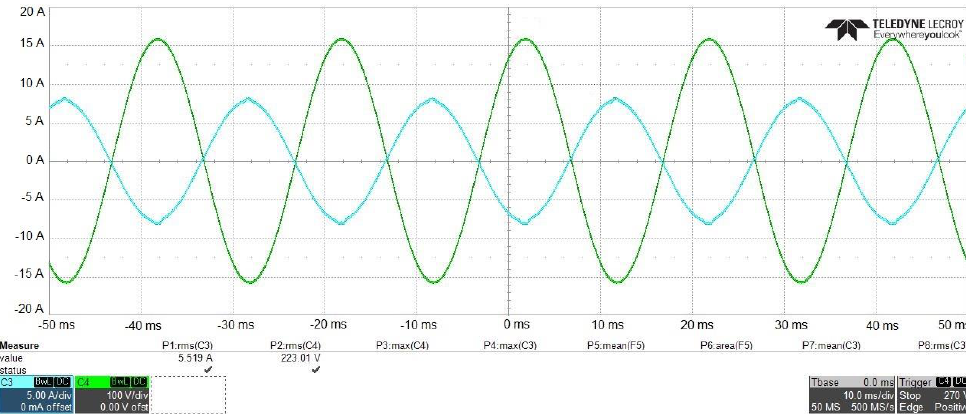
Figure 23. Mains voltage (C4, green) and current (C3, blue) at 26 kHz. The power value is adjusted by changing the switching frequency. As the switching frequency approaches the resonant frequency, the power transferred to the load increases in the inductive region. Due to the low value of the input filter capacitor, the input current waveform is close to sinusoidal. Therefore, power-factor correction (PFC) is not required at the circuit input. The voltage and current waveforms of the transmitter coil are given in Figures 24–27 for different switching frequencies. It can be seen from the waveforms that the coil current has an inductive characteristic. As the switching frequency approaches the resonant frequency, the current waveform becomes sinusoidal because of the resistance load characteristic. Figure 24. Transmitter coil voltage (C4, green) and current (C3, blue) at 75 kHz.